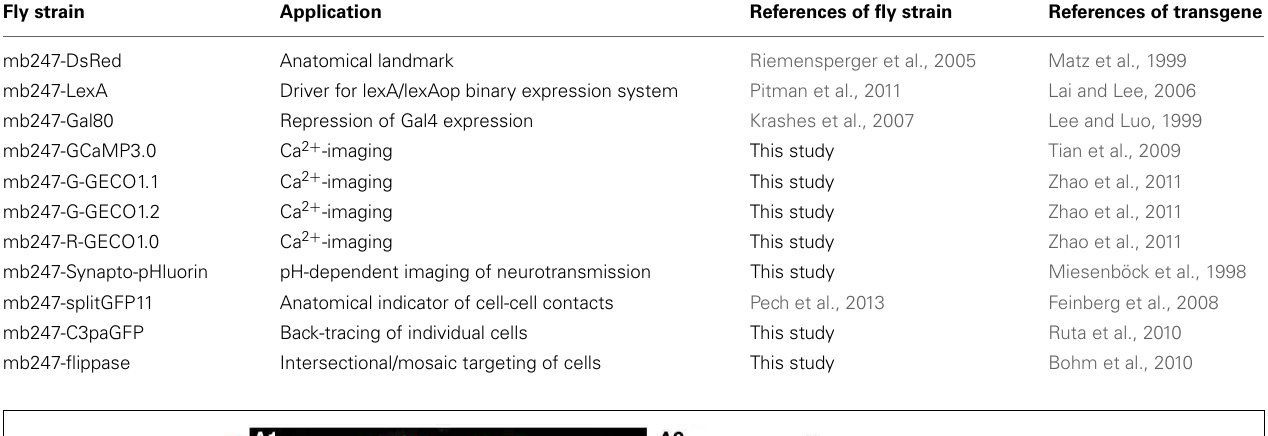
Table 1 | Summary of fly strains expressing transgenes directly under control of the duplicated mb247-promoter.